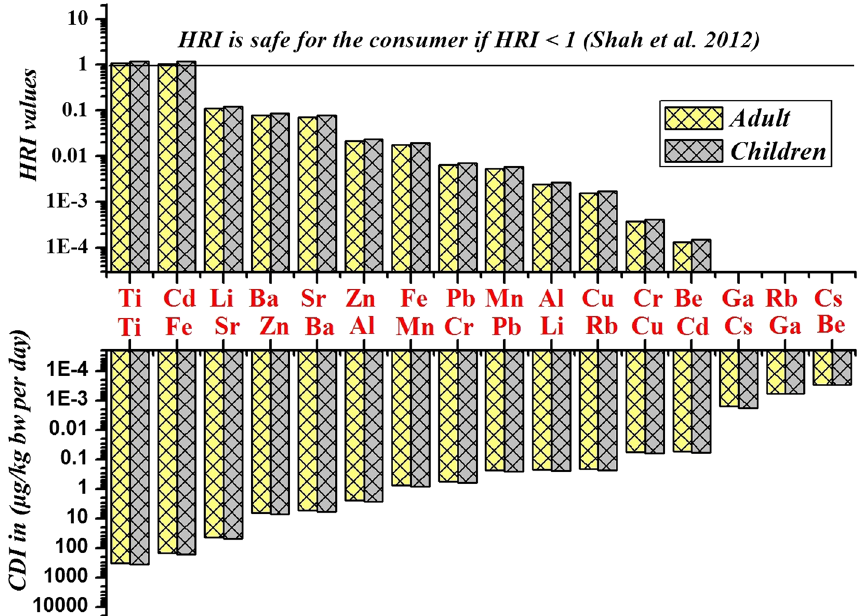
Fig. 3 The mean CDI (µg/ kg- bw per day) values and HRI of heavy metals considered for drinking water